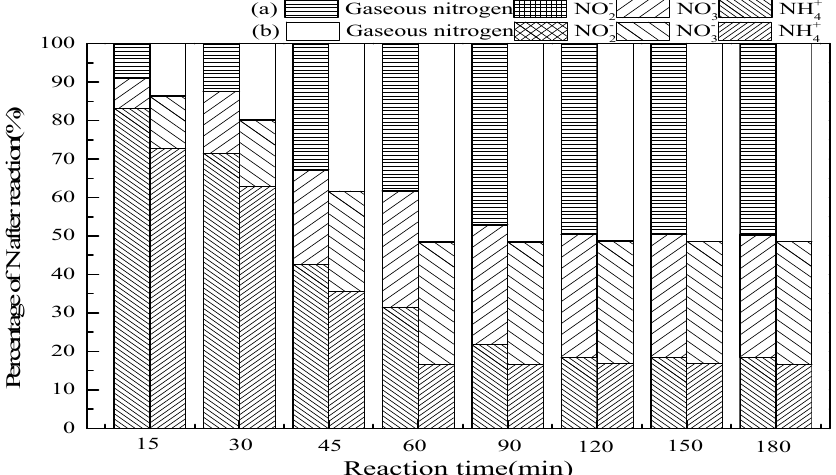
Figure 4. The effect of reaction time on ammonia conversion. Reaction conditions: initial NH 4+ concentration 50 mg/L, initial pH 9.5, ozone flow 1.5 g/h, catalytic dosage 2.0 g/L, temperature 25 °C, reaction time from 15 to 180 min, ultrasonic frequency 25 kHz, ultrasonic power 270 W, ultrasonic operation 1 s and interval 2 s. ( a ) SrO-Al 2 O 3 /O 3 , ( b ) SrO-Al 2 O 3 /US/O 3.